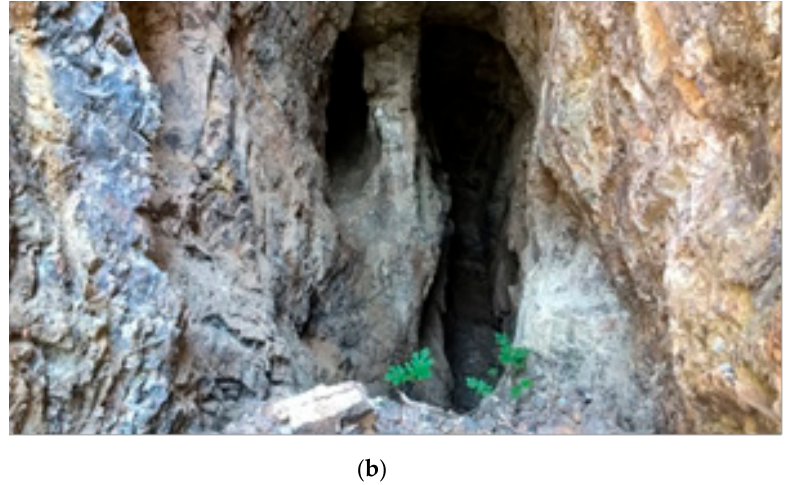
Figure 3. Paleozoic rocks ( a ) and old shafts ( b ) at Chios Isl. (Keramos abandoned mines) where Sb-bearing samples were collected.